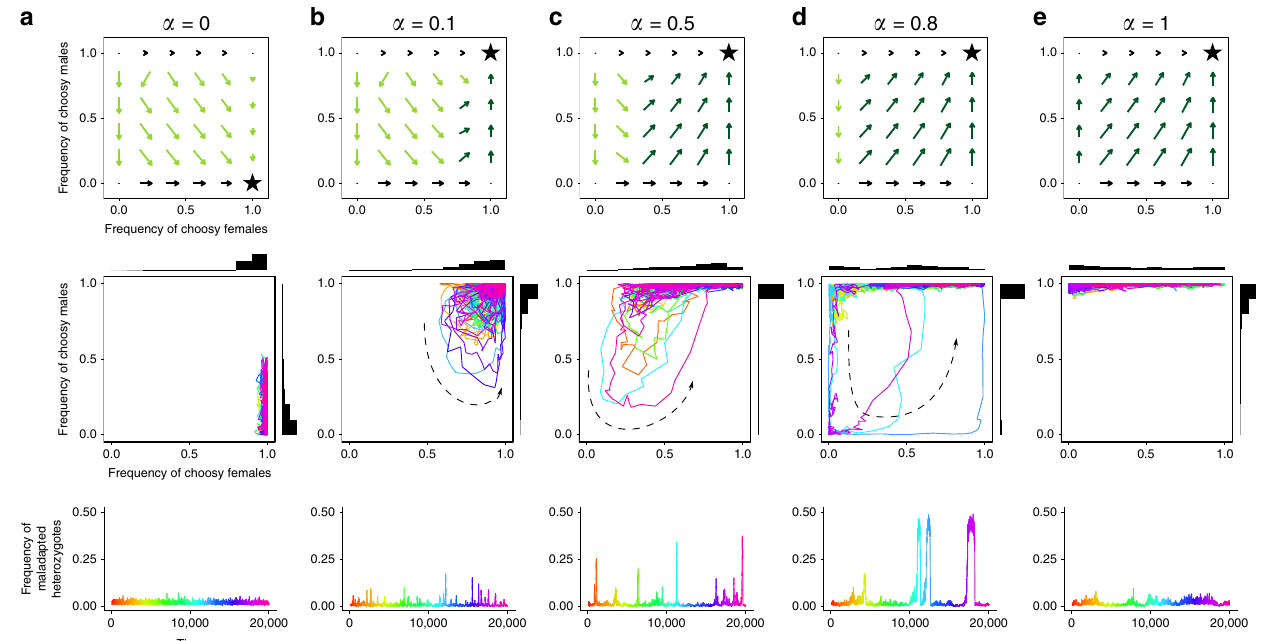
Fig. 4 Selection gradients for female and male choosiness and examples of stochastic simulations ( s ¼ 0 : 2, K ¼ 500) with different courtship reallocation values ( α ). From top to bottom, we represent the deterministic selection gradients for female and male choosiness, the evolutionary dynamics of choosiness, and the resulting frequencies of maladapted heterozygotes at the ecological locus before viability selection (from the same simulations). The selection gradients for choosiness correspond to the relative change in frequencies of choosy versus nonchoosy females and males over one entire generation (net effect of viability and sexual selection combined) in the deterministic model, and are therefore simpler than the representation in Fig. 2b – f. To highlight weak selection on choosiness, the length of arrow vectors is drawn on a logarithmic scale. Stars correspond to the regimes of choosiness at deterministic equilibrium. The graphs in the second and third rows show stochastic simulations, started at the choosiness regime predicted by the deterministic analysis, and rainbow color gradients correspond to the passage of time. Note that in b – d , the stochastic simulations do not converge to the deterministic equilibrium, but instead display “ preference cycling ” , the direction of which is represented by a dashed